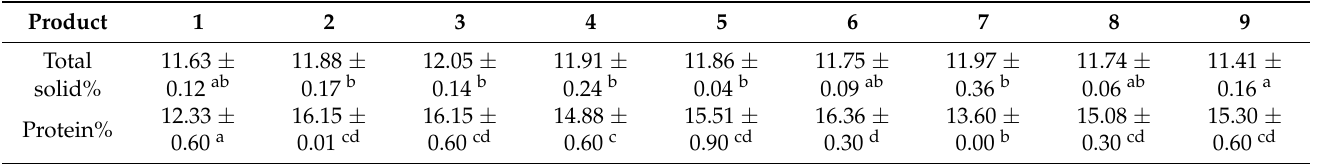
Table 6. Effect of addition of FM and GA on total solid and protein content after the storage time.